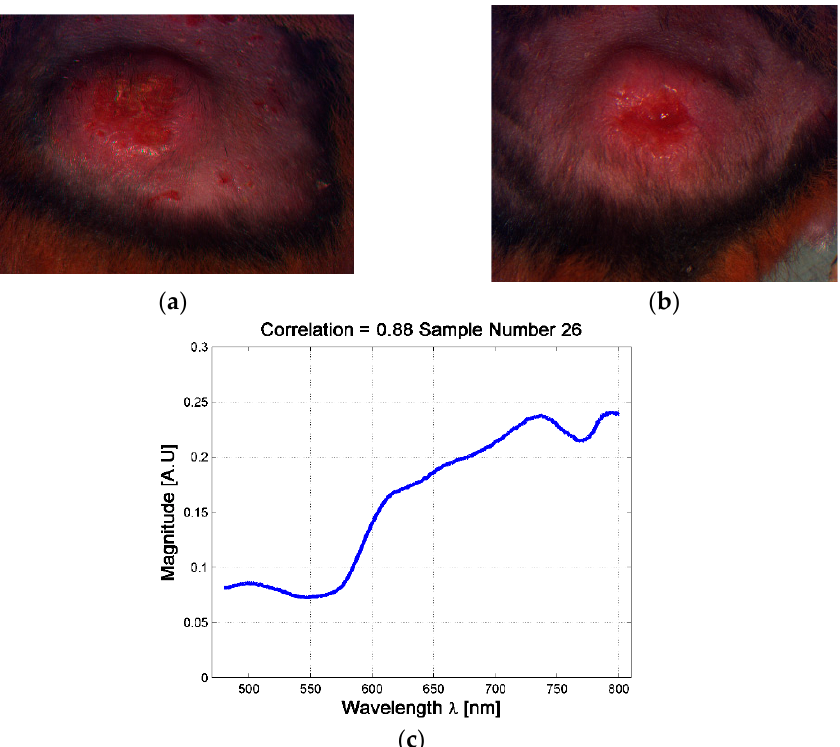
Figure 5. Example of skin ulcers with different sizes and similar spectral signatures at the center of the skin ulcer. ( a ) skin ulcer of Hamster 763-MAD-Date 3; ( b ) Skin ulcer of Hamster 762-MAI—Date 3; ( c ) example of the mean spectra at the center of the skin ulcer.